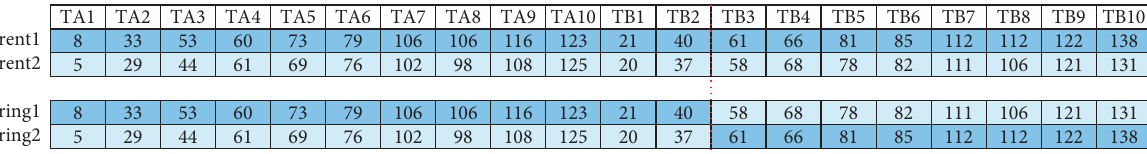
Figure 4: Representation of crossover.